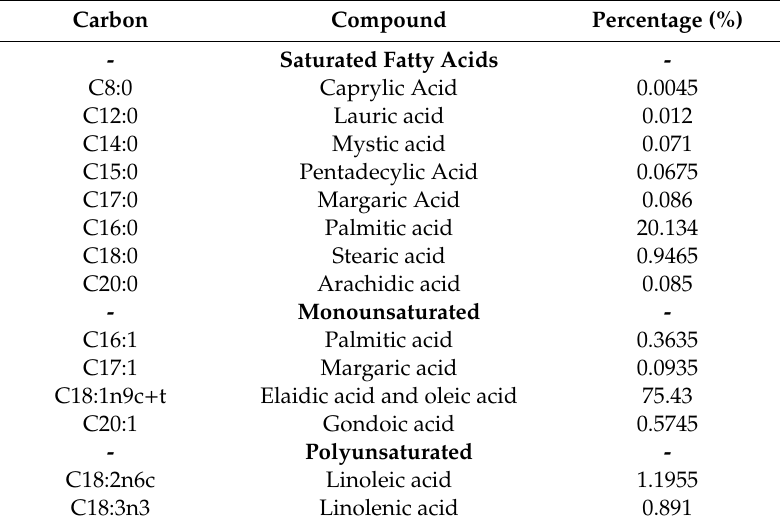
Table 2. Fatty acids composition of buriti